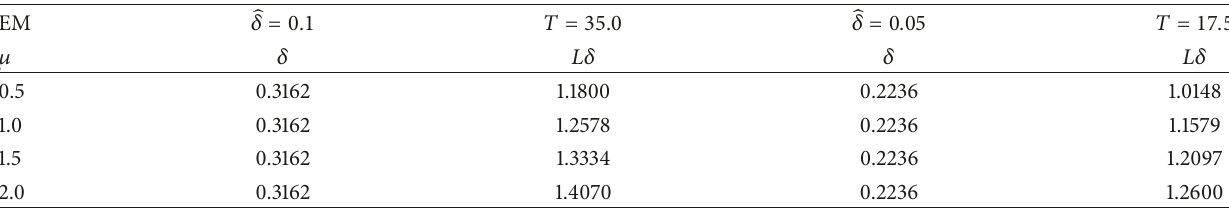
Table 1: Summaries of the parameters for stochastic logistic